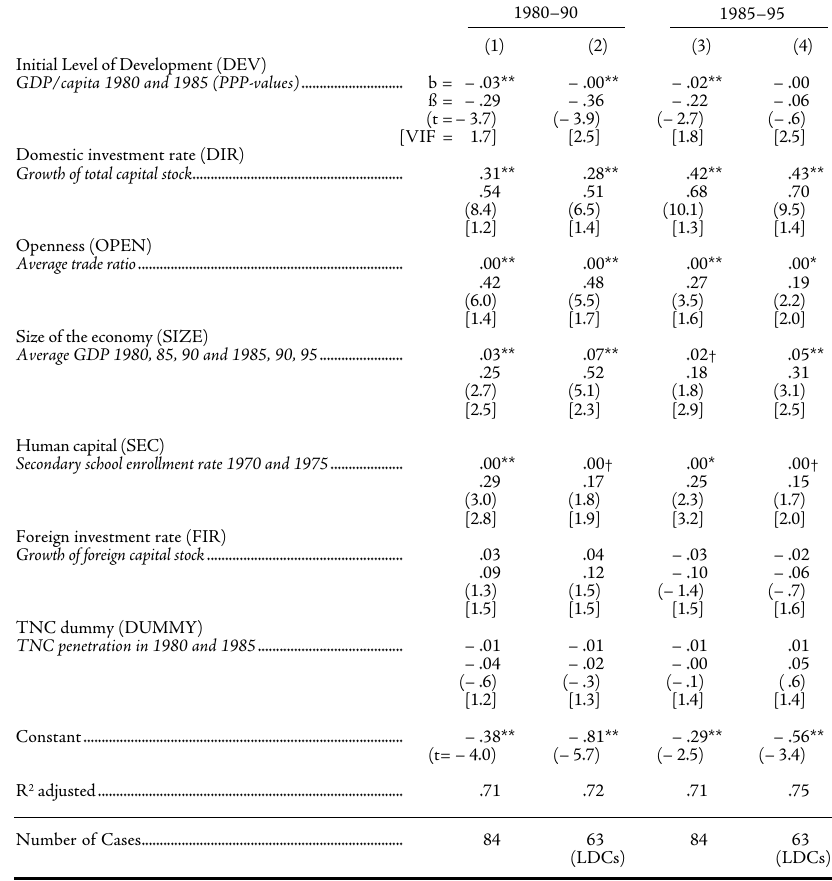
Table 1 – Dependent Variable: GDP per capita growth; OLS